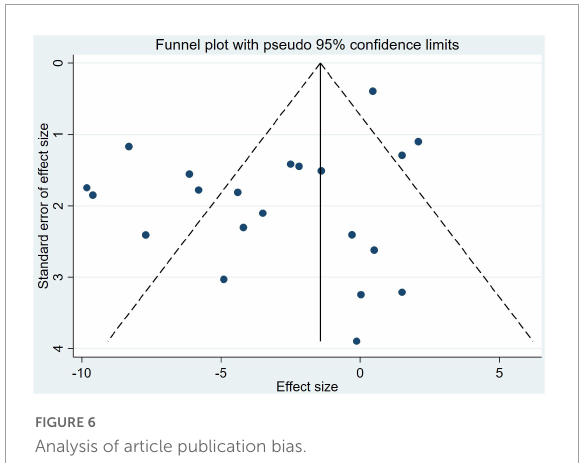
FIGURE6 Analysis of article publication